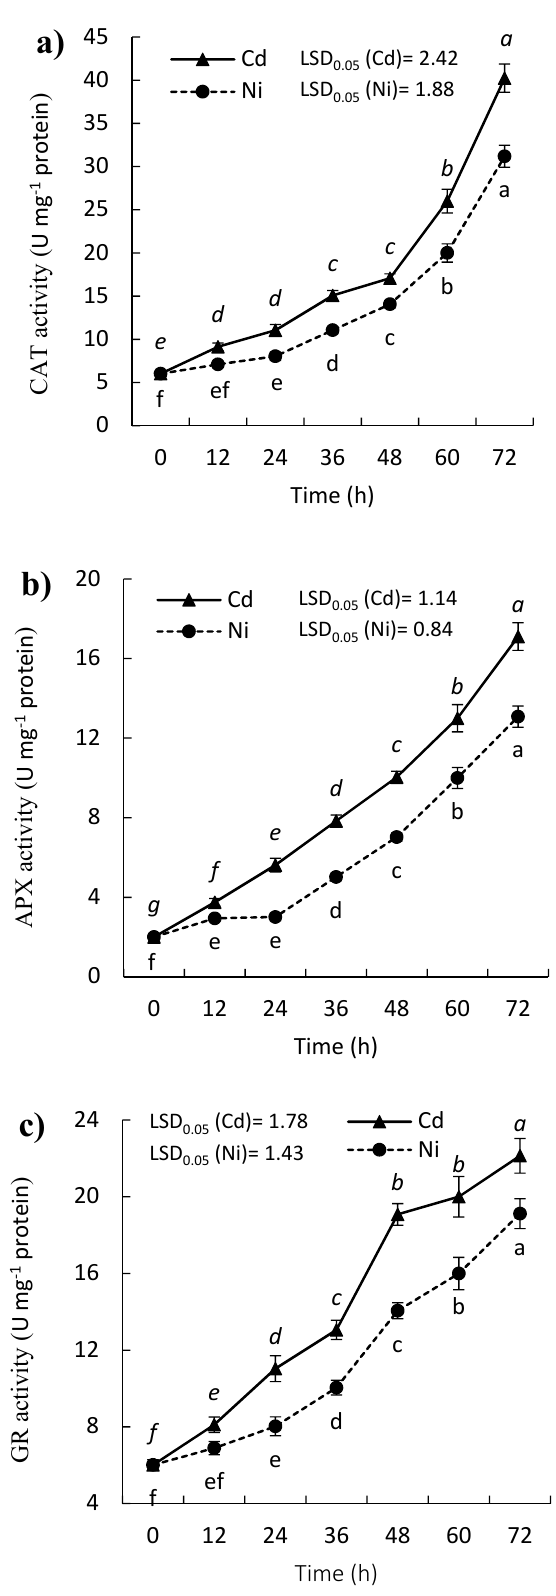
Figure 4. Effect of Cd and Ni on ( a ) catalase (CAT), ( b ) ascorbate peroxidase (APX), and ( c ) glutathione reductase (GR) activities in the leaves of P. sativum with time. Different letters per each line mean a significant difference ( p ≤ 0.05 ). Values are average of means ( n = 6 ) and bars represent the standard error. LSD 0.05 is the least significant difference at the probability level of 0.05.